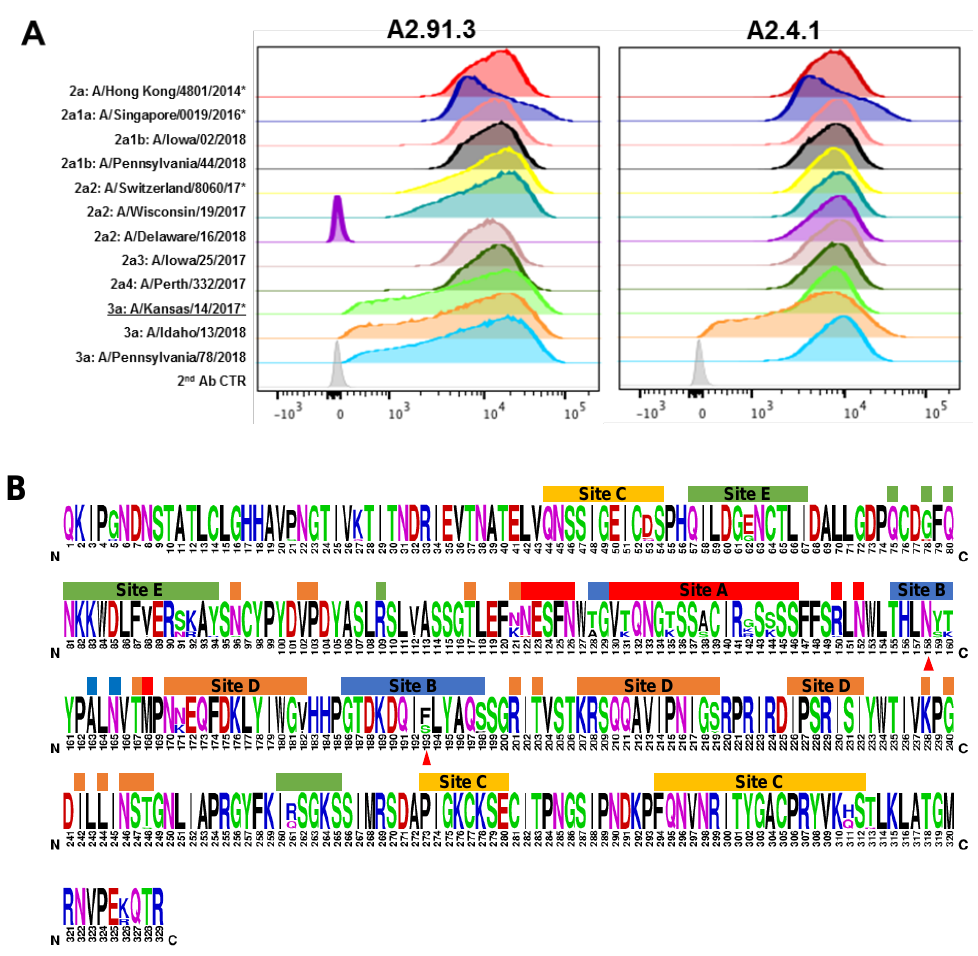
Figure 3. Fluorescence-activated cell sorting (FACS) analysis of antibodies binding to a panel of contemporary H3N2 HAs. ( A ) Sf9 cells were infected with recombinant baculovirus with the H3N2 HA transgene at an MOI of 0.001 per cell for 48 hours. Post-infection Sf9 cells were co-labeled with stem antibody CR8020 for gating of HA expression and either A2.91.3 or A2.4.1. Staining with RBS A2.91.3 and VE subdomain A2.4.1 showed differential binding of these antibodies to contemporary H3N2 strains with various mutations in the HA protein. * Indicates WHO H3N2 vaccine strains. ( B ) Sequence logo of HA1 for the 12 contemporary H3N2 strains tested by FACS. Amino acids shown at full height were conserved across all tested strains versus amino acid diversity shown by percentage related to total height. Antigenic sites were labeled according to Munoz et al. [36] and the N158 glycosylation site and F193S mutation site were marked with red triangles.